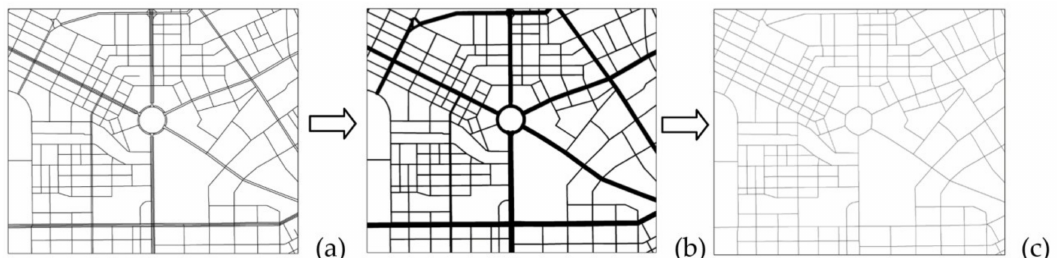
Figure 2. OpenStreetMap (OSM) data processing flow diagram. ( a ) Filtered OSM; ( b ) bu ff er zones; ( c ) centerlines.